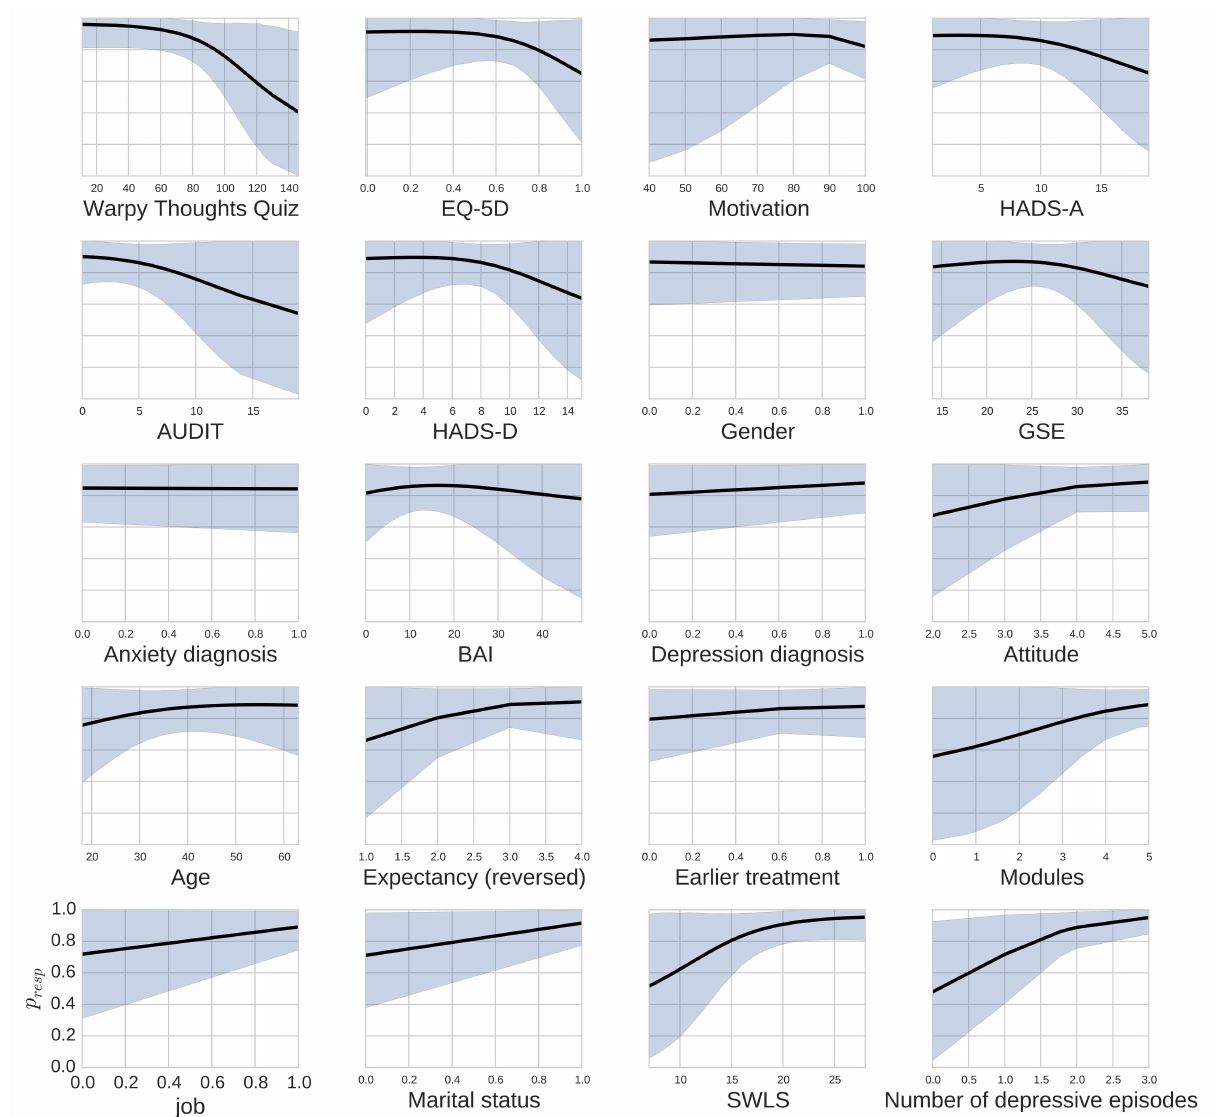
Figure 2. Probability of being in the responder group as a function of the predictor variables (assuming all other predictors remained at their baseline level). Black line is the mean posterior probability and shaded area is the 95% highest density